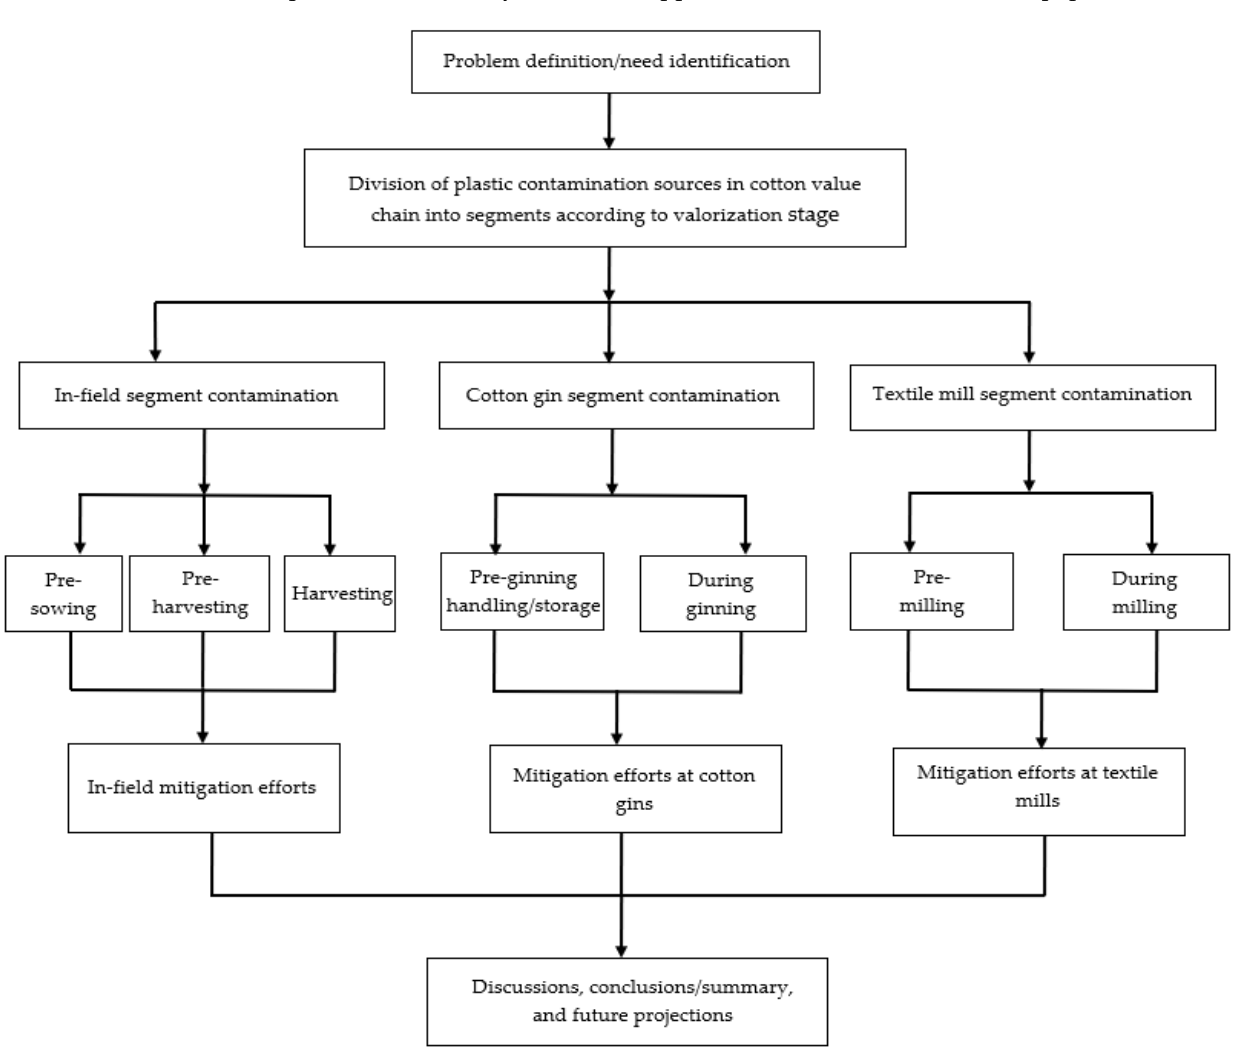
Figure 1. A flowchart summarizing the framework/workflow adopted in this review article.